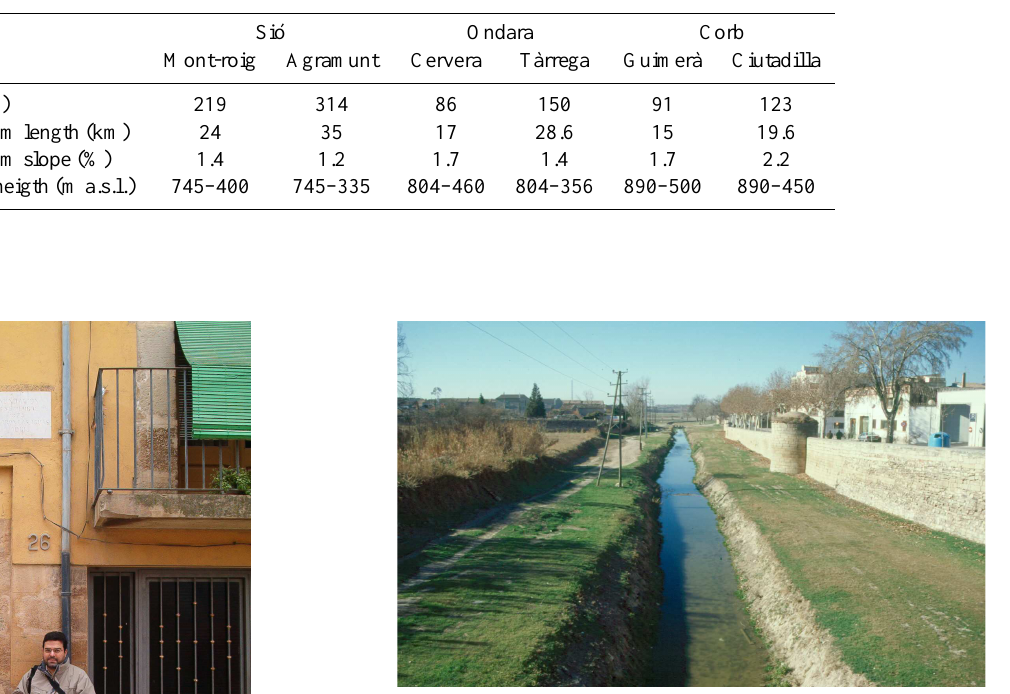
Fig. 4. The Ondara River at T`arrega; 1874’s river bed was three metres below the current